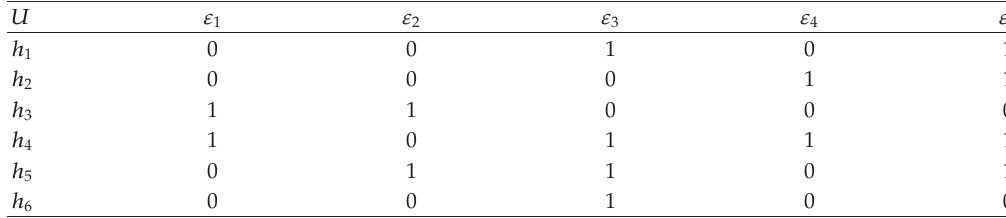
Table 4: Tabular representation of the level soft set L (cid:5) S ; 0.6, 0.5 (cid:6) .